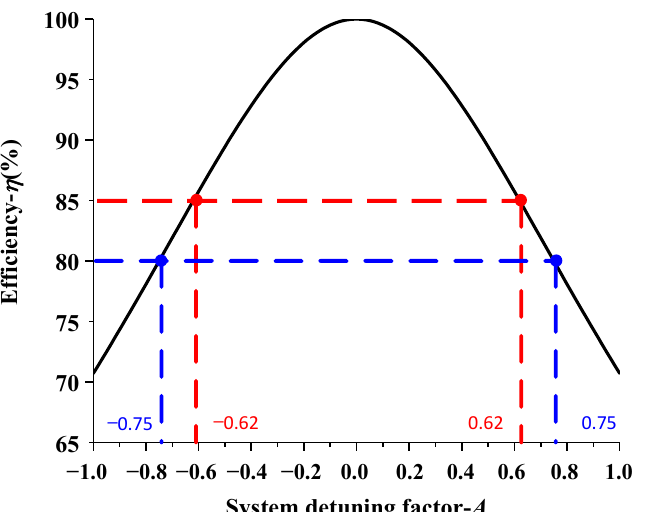
Figure 4. Relationship between system detuning factor A and transmission efficiency η.